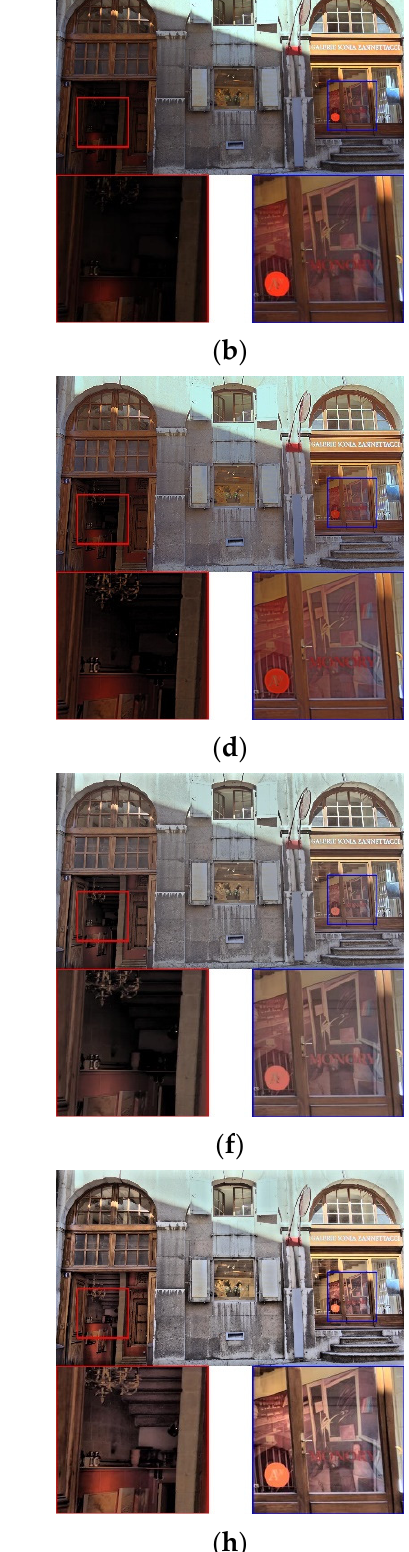
Figure 9. Visual comparison using the test image C33_Store. ( a ) Result of [4]. ( b ) Result of [9]. ( c ) Result of [13]. ( d ) Result of [25]. ( e ) Result of [14]. ( f )Result of [17]. ( g ) Result of [18]. ( h ) Result of the proposed